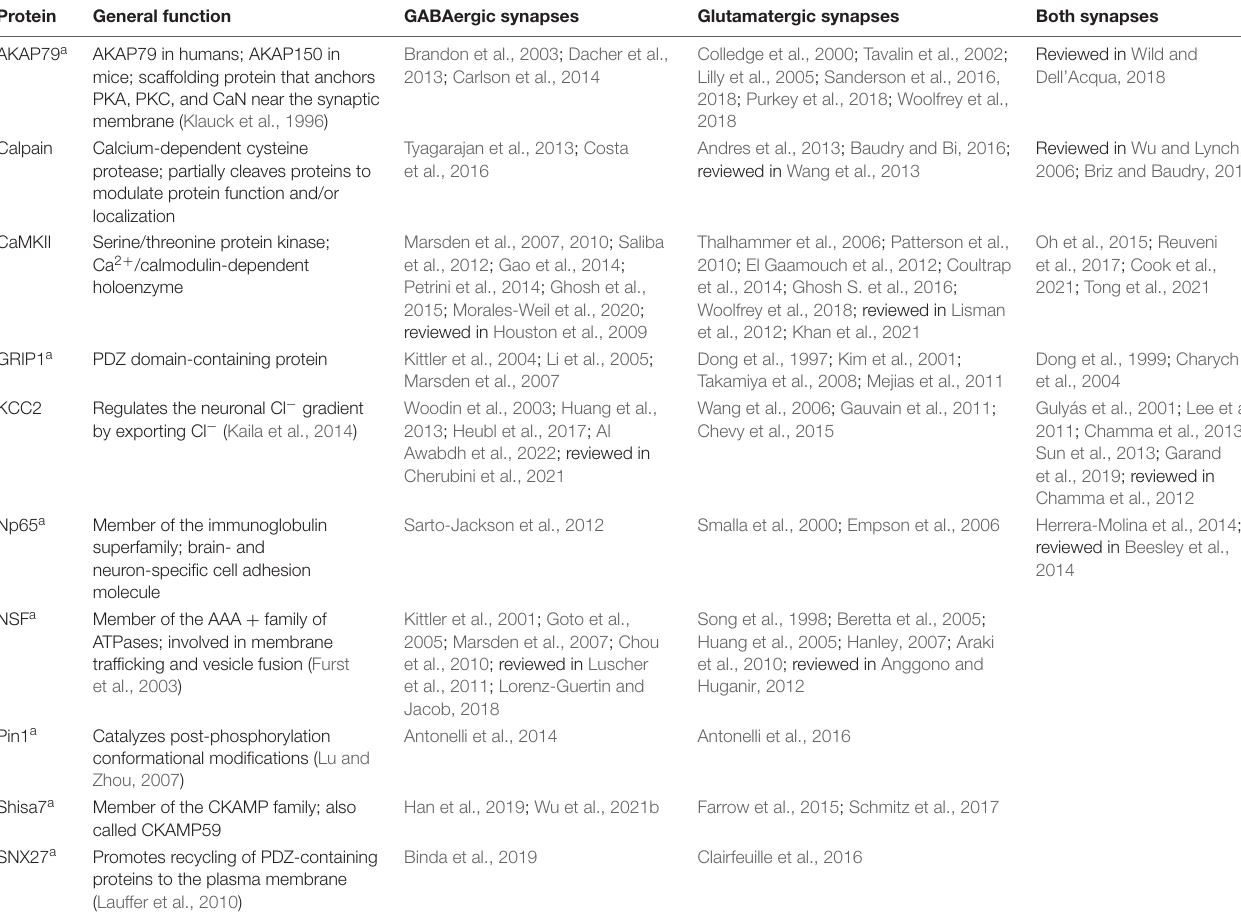
TABLE 1 | Potential crosstalk proteins implicated in plasticity at both GABAergic and glutamatergic synapses.